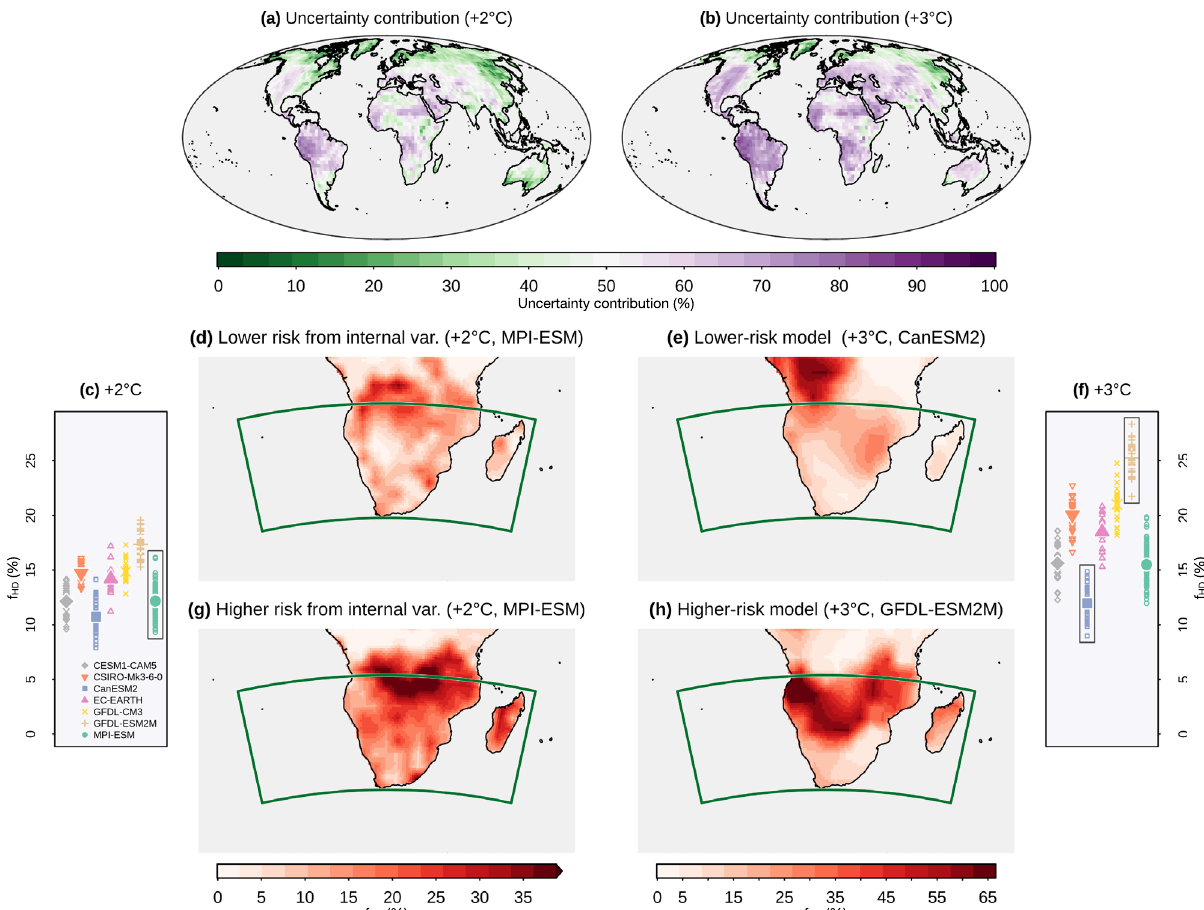
Fig. 6 | Model differences dominate internal climate variability at higher warming levels. a , b Uncertainty in the frequency of compound-hot-dry events ( f HD ) due to model-to-model differences ( U MD ) relative to the sum of U MD and the uncertainty due to internal climate variability ( U IV ) in a world 2°C ( a ) and 3°C ( b ) warmer than pre-industrial conditions (expressed in percentage; uncertainty is dominated by model-to-model differences for values above 50% and by internal climate variability otherwise). c , f Average of the future f HD over Southern Africa (green box in d ) according to individual ensemble members of different climate models in a 2°C and 3°C warmer world, respectively (larger symbols indicate